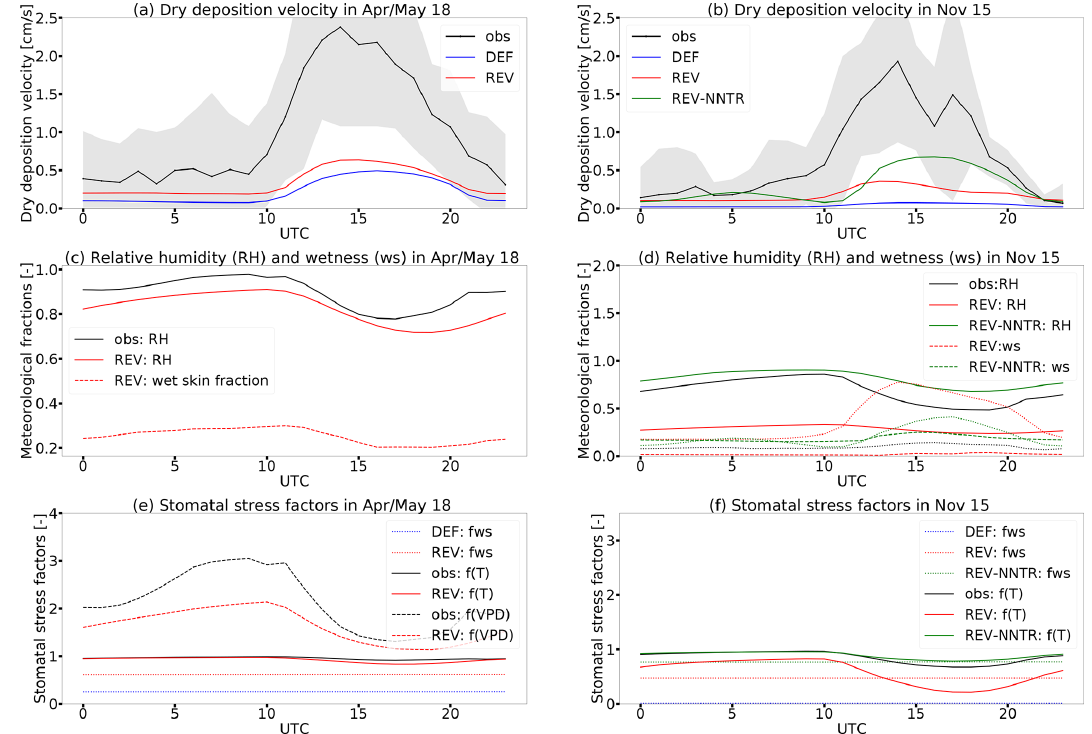
Figure 5. Diurnal cycles of measured (obs) and modelled (DEF, REV, REV-NNTR: free-running f (T ) and f ( VPD ) for evapotranspiration) ozone dry deposition velocities in wet and dry seasons at ATTO (gray: standard